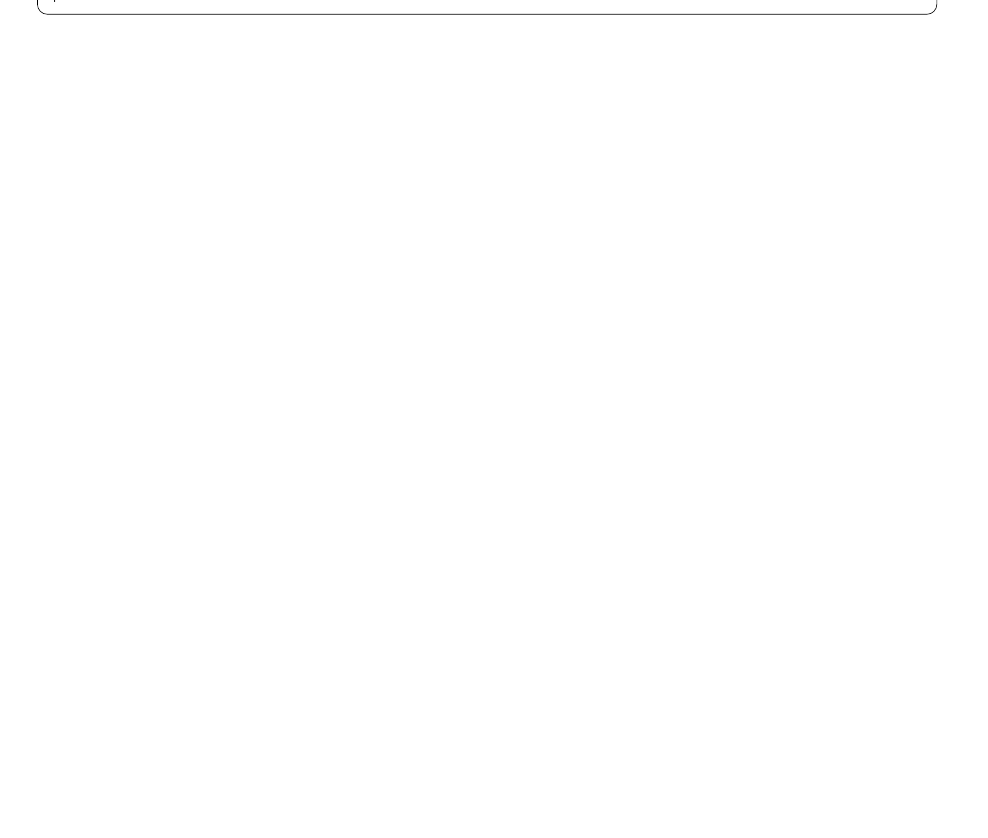
Fig. 19 Example curve element with embedding: two coupled curves with boundary conditions inside the